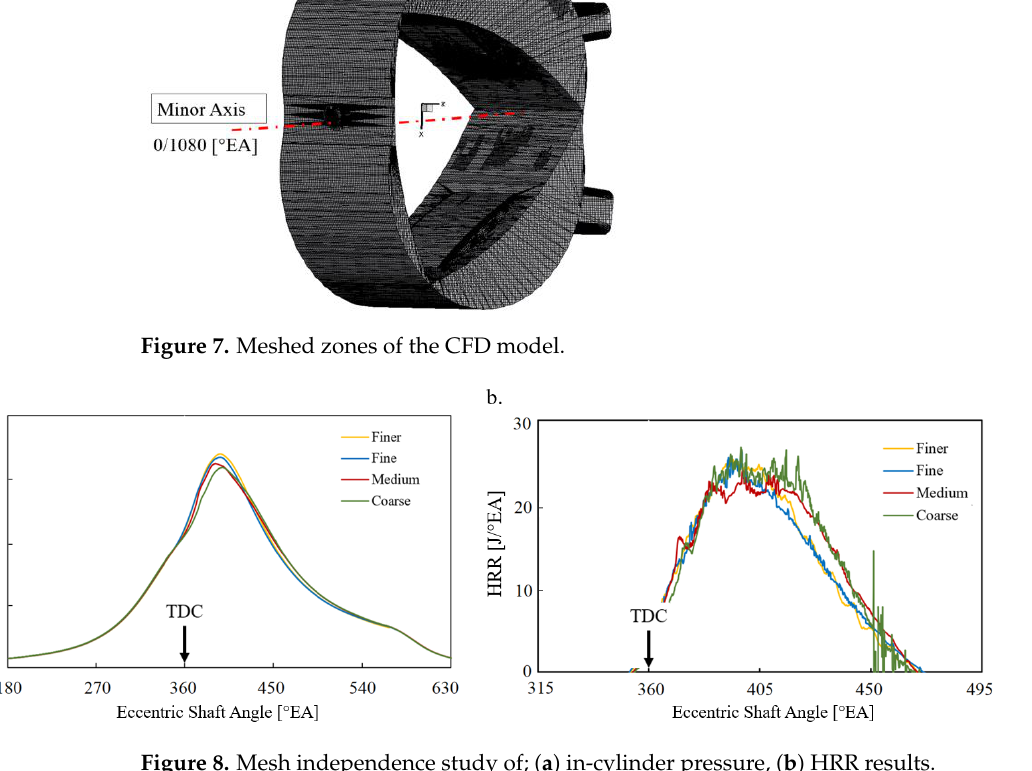
Figure 7. Meshed zones of the CFD model.